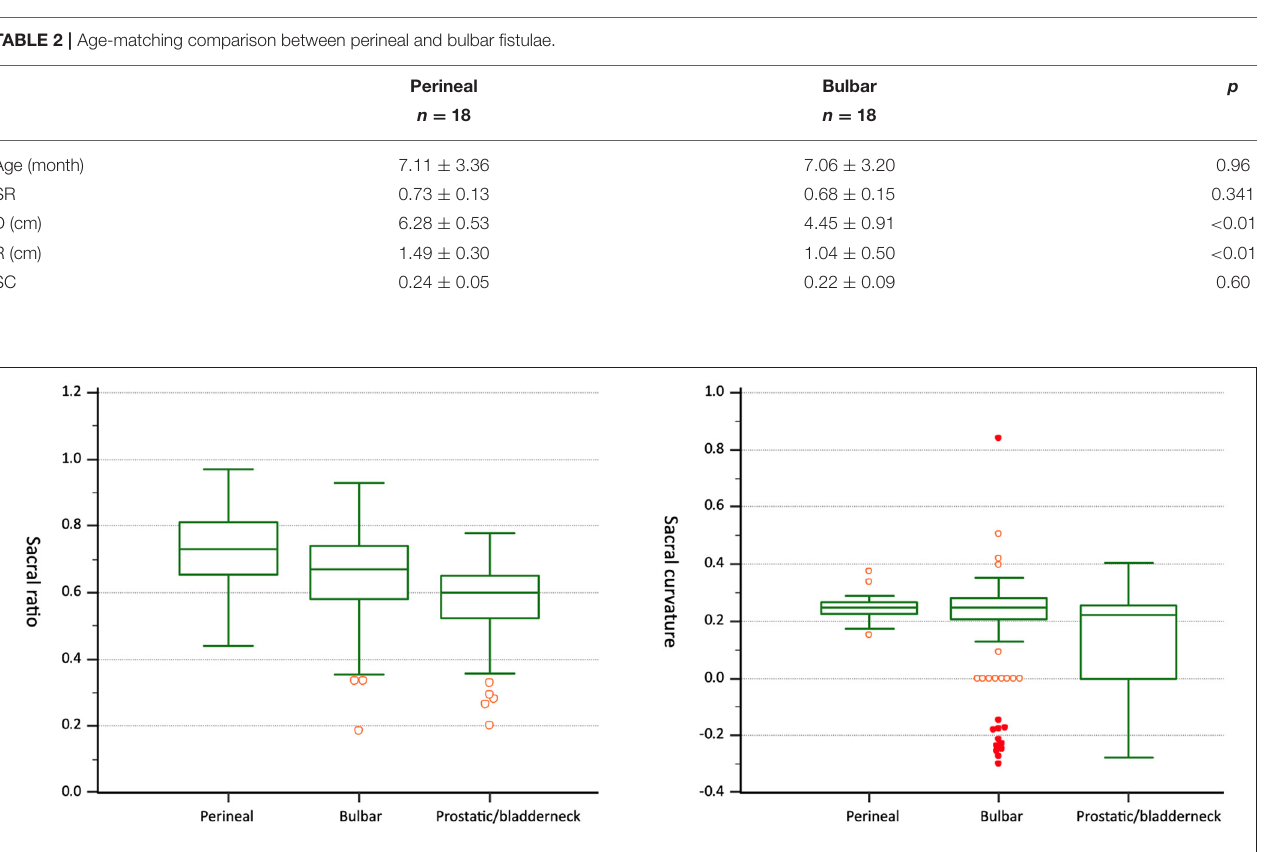
FIGURE 3 | SR was significantly different between the three groups. SC of prostatic/bladderneck fistulae was significantly lower than those of perineal and bulbar